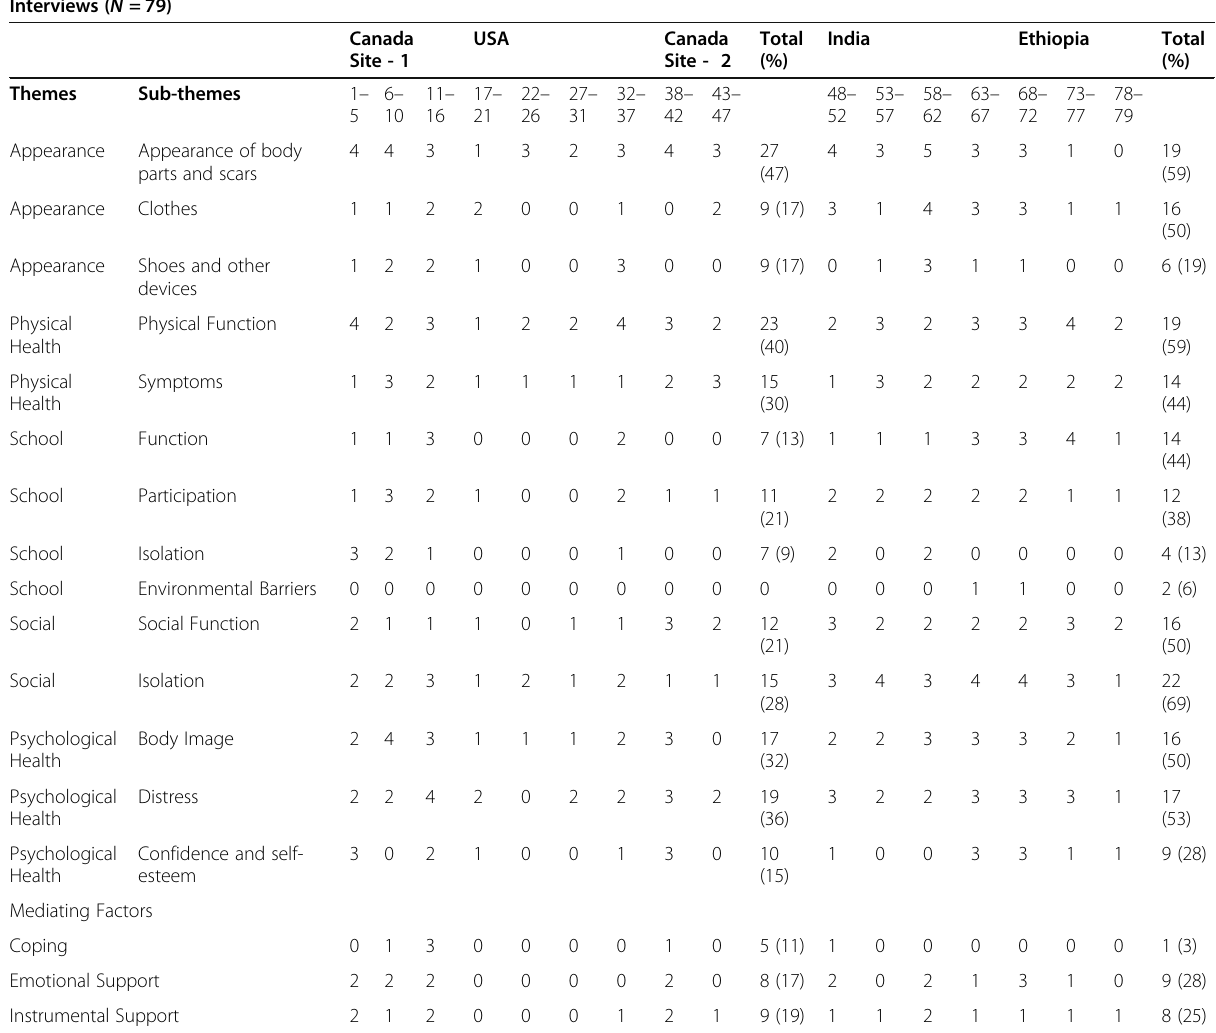
Table 3 Saturation Table Showing the Number of Interviews Endorsing Each Theme and